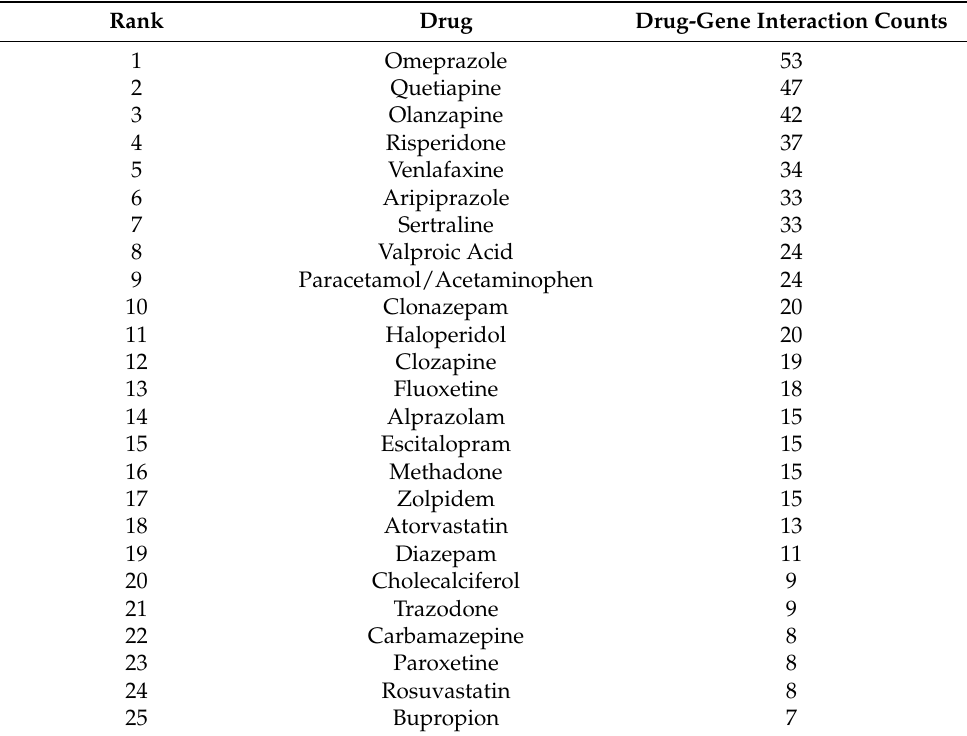
Table 2. Top 25 medications involved in potential drug–gene interactions in study population.